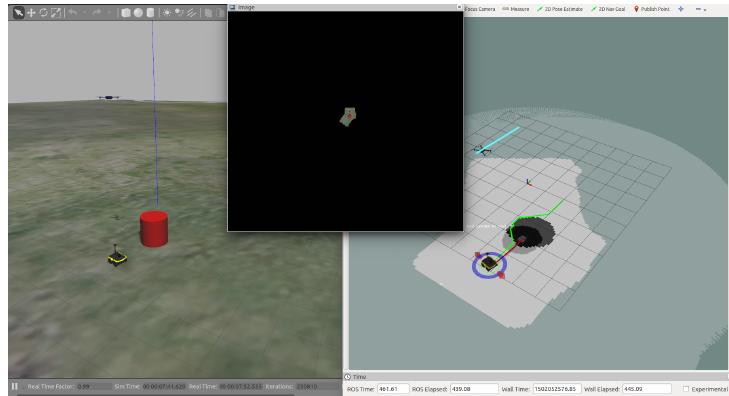
Figure 10. This simulation illustrates the issue of parallax error in the estimated obstacle location. The left half of the figure displays the Gazebo simulation environment, featuring a ground vehicle, an aerial vehicle, and the obstacle. The right half of the figure displays two obstacle maps overlaid on one another. The ring shaped region shows the perimeter of the object as seen by the ground vehicle, while the solid, larger circle displays the obstacle as detected by the aerial vehicle. Note the offset between them as well as the difference in estimated size which is due to the position of the aircraft directly above the ground vehicle and offset from the center of the